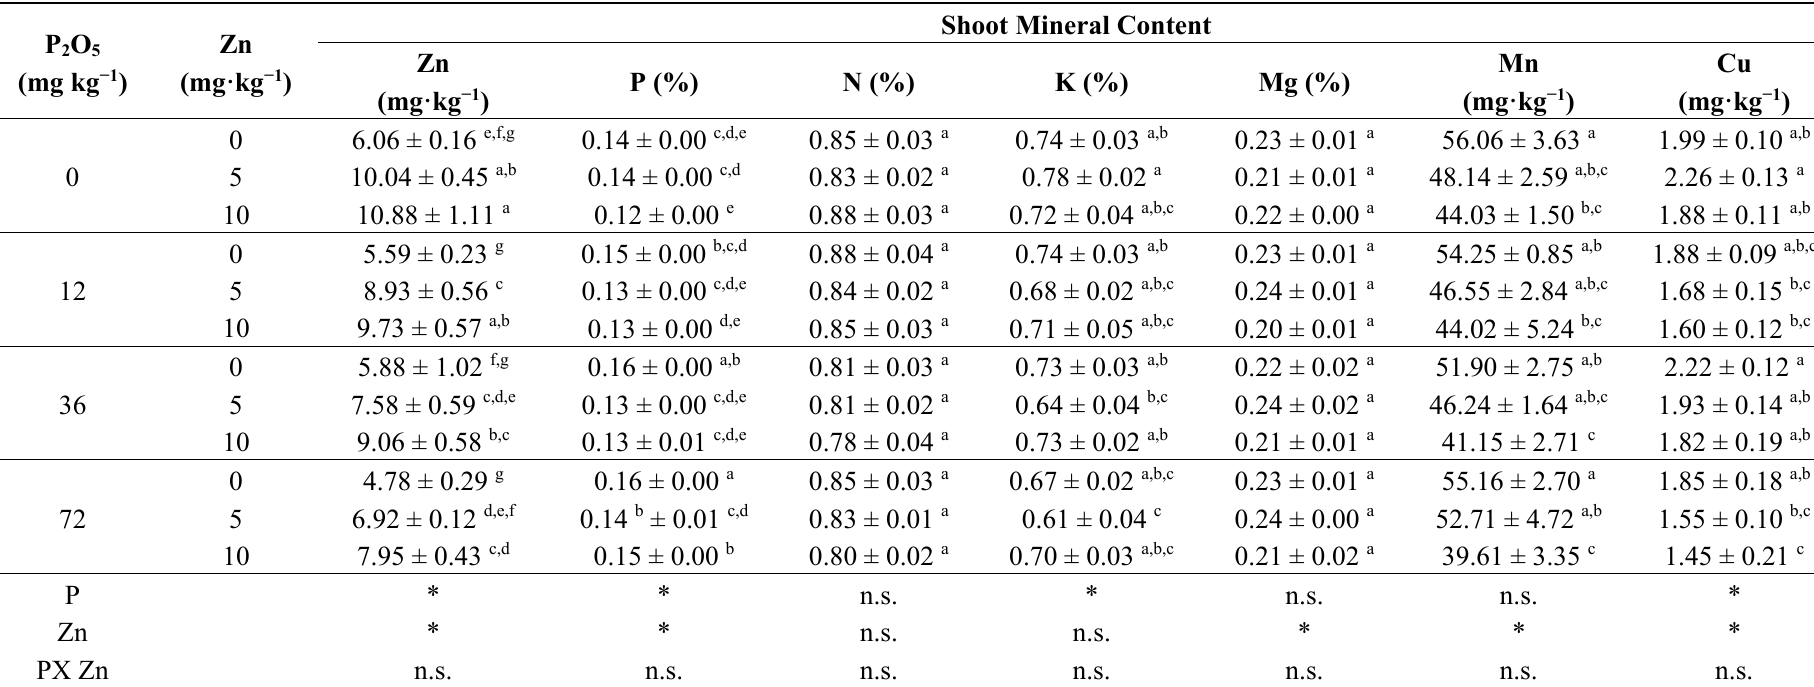
Table 5. Effect of zinc and phosphorus supply on shoot mineral content of corn silage at